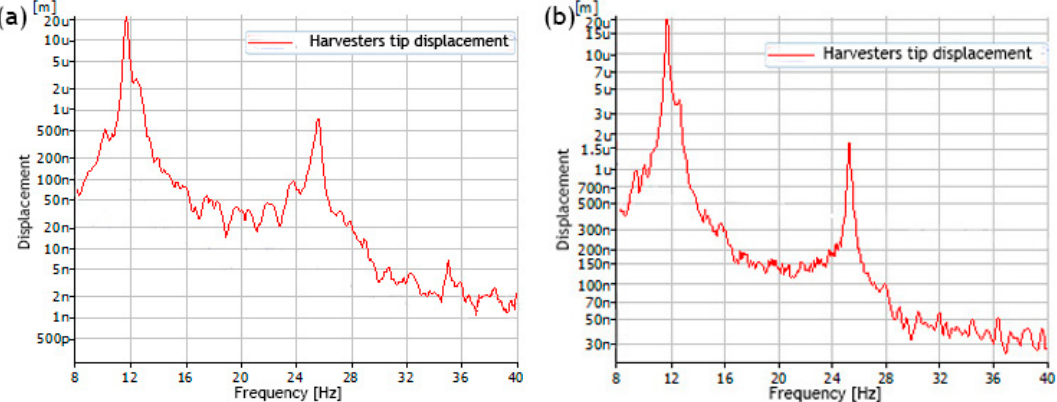
Figure 15. Frequency response characteristics of the bidirectional harvester when excitation direction align with y axis ( a ) and z axis ( b ).